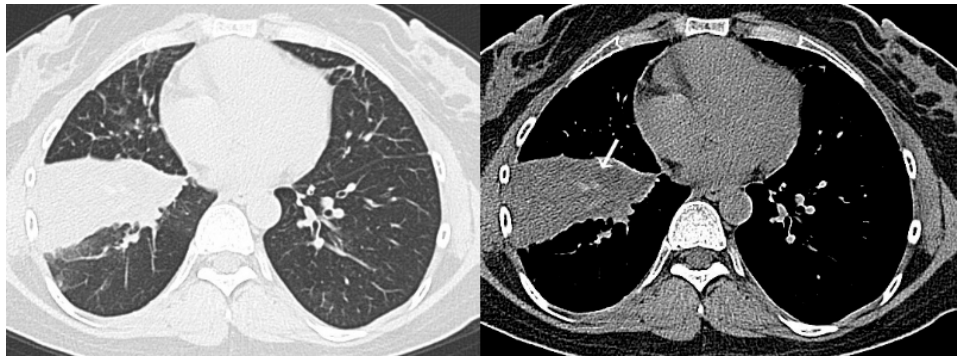
Figure 5. Representative CT images of a COVID-19-negative patient. Thirty-four-year-old female. The CT images show segmental consolidation with mucus plug (arrow). RT-PCR was negative for SARS-CoV-2 and she was diagnosed with community-acquired pneumonia. All readers diagnosed it as Category 2. COVID-19, coronavirus disease 2019; CT, computed tomography; RT-PCR, reverse transcription-polymerase chain reaction; SARS-CoV-2, severe acute respiratory syndrome coronavirus 2. Table 5. Characteristics of false-positive cases in chest CT.